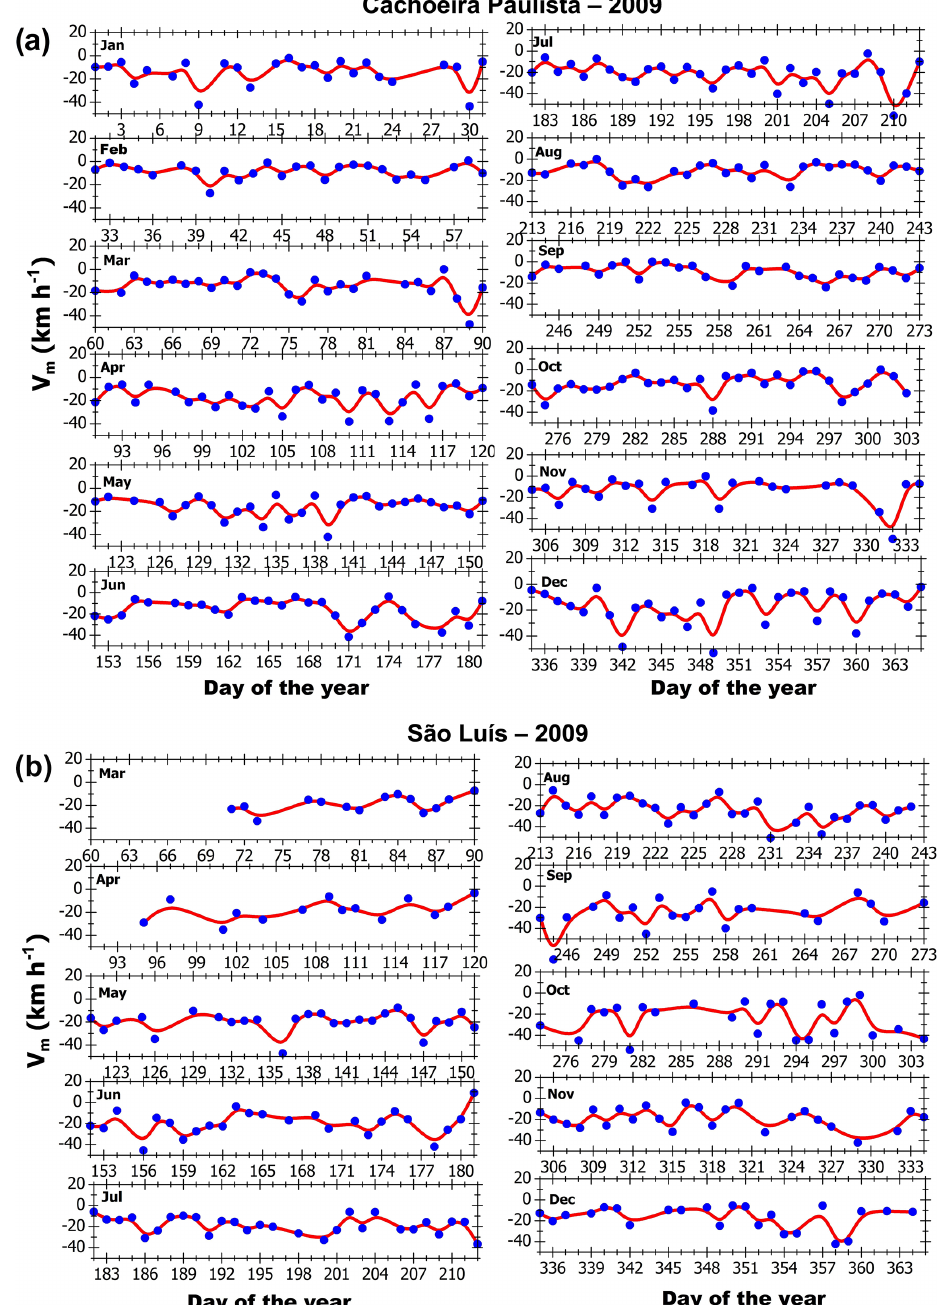
Figure 14. The descending velocity of the intermediate layers for (a) Cachoeira Paulista and (b) for São